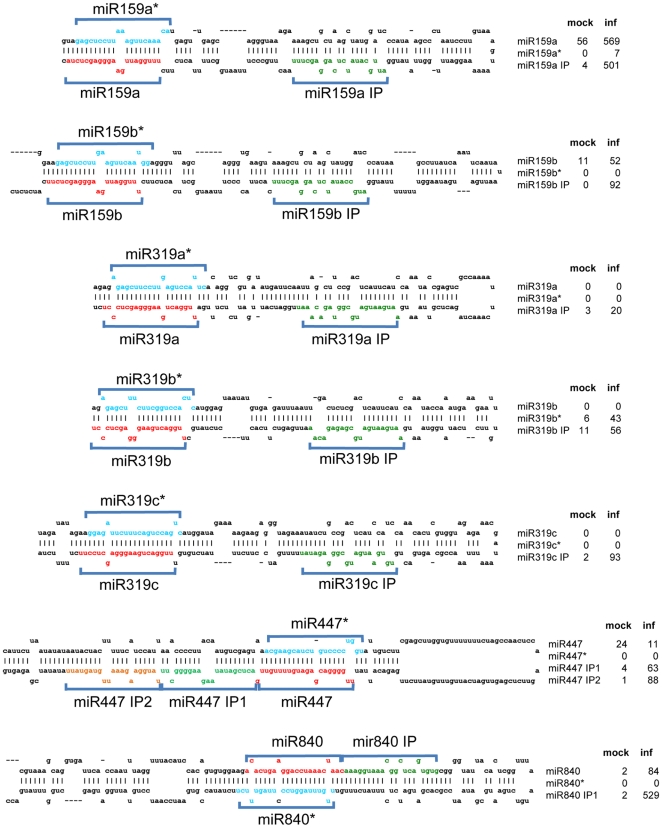
ml-siRNAs produced from miRNA precursor RNAs upon infection.The foldback structures of several miRNA precursor RNAs are shown. The
sequences of mature miRNAs and miRNA* sequences are indicated in red
and blue color, respectively. ml-siRNAs are depicted in green and yellow
color. Since the ml-siRNAs are produced in phase (IP) with the miRNA and
miRNA* sequences, they are designated according to the particular
miRNA with the extension “IP” (for example, “miR159
IP”). The normalized reads (RPM) obtained for miRNAs, miRNA*,
and ml-siRNA sequences for mock-treated (mock) and ORMV-infected plants
(inf) are shown.